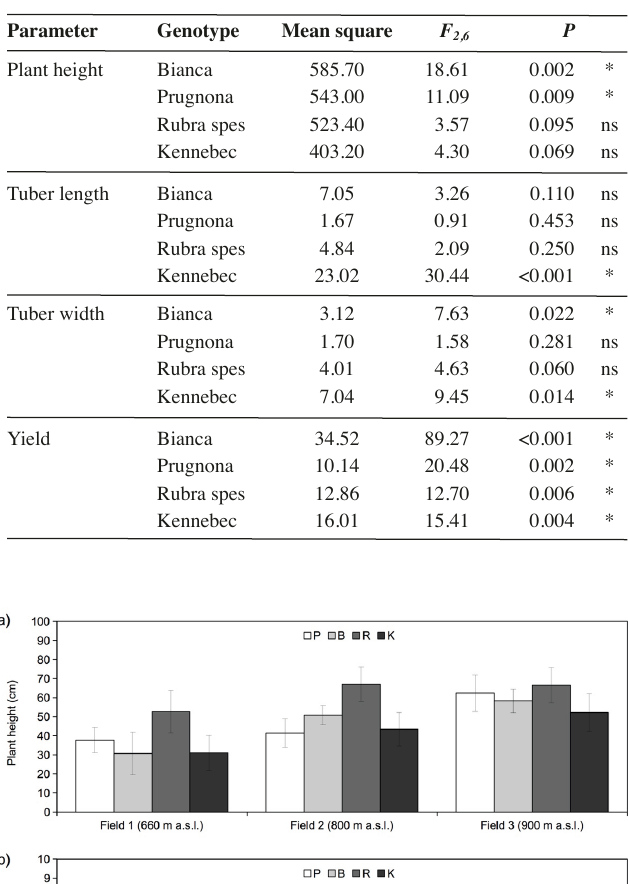
Tab. 5: ANOVA results of experimental field effect on biological and ag - ronomic features of each potato genotype. Key: *, significant ( P < 0.05); ns, not significant.